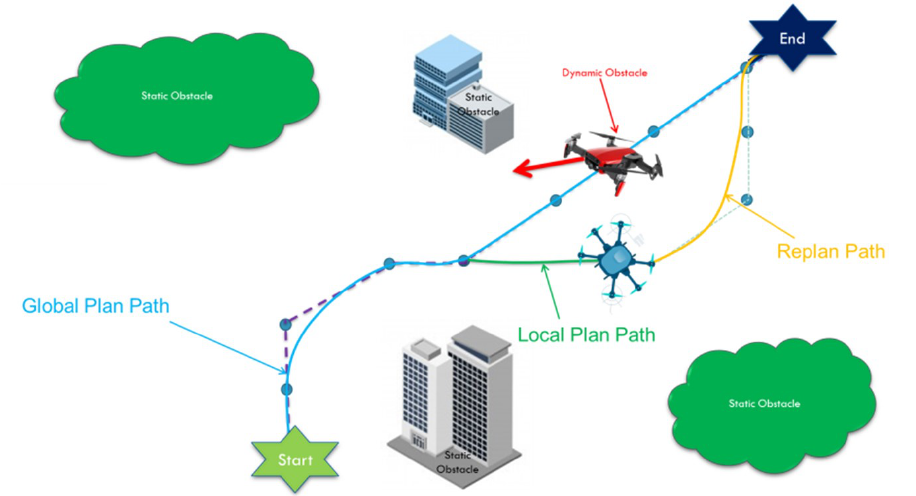
Figure 2. Real-time mission of a UAV with globally and locally planned